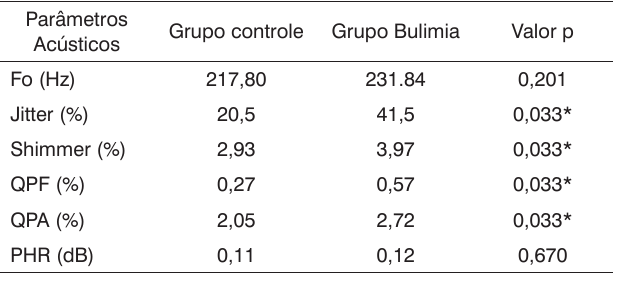
Tabela 3. Valores médios dos parâmetros acústicos nos grupos